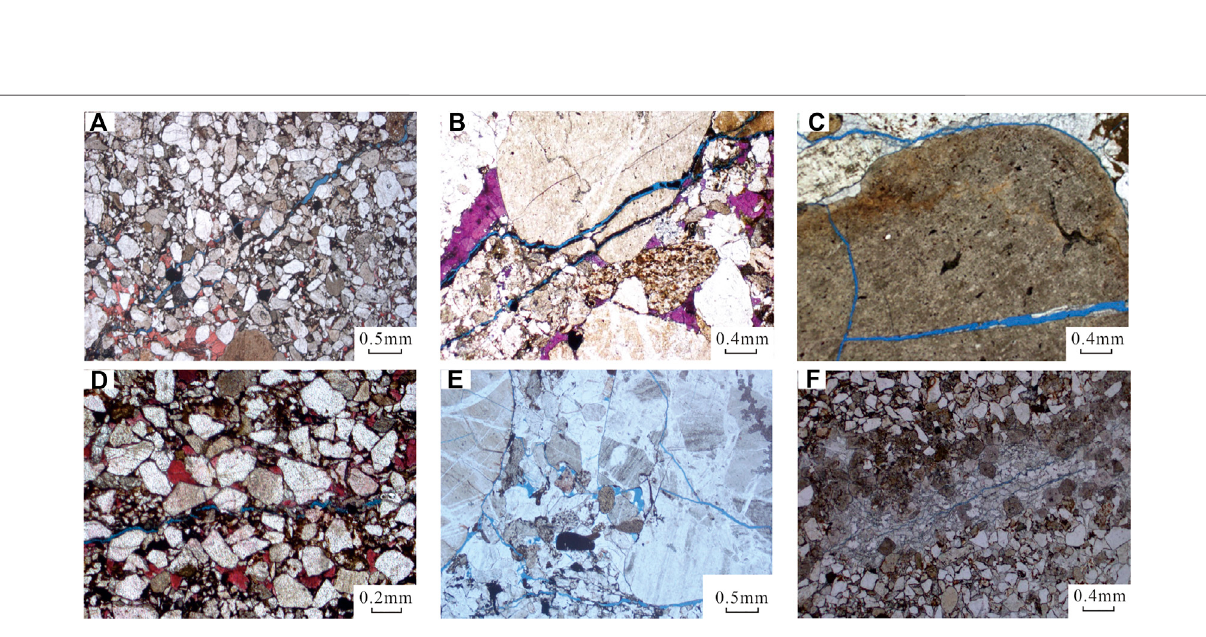
Frontiers in Earth Science |